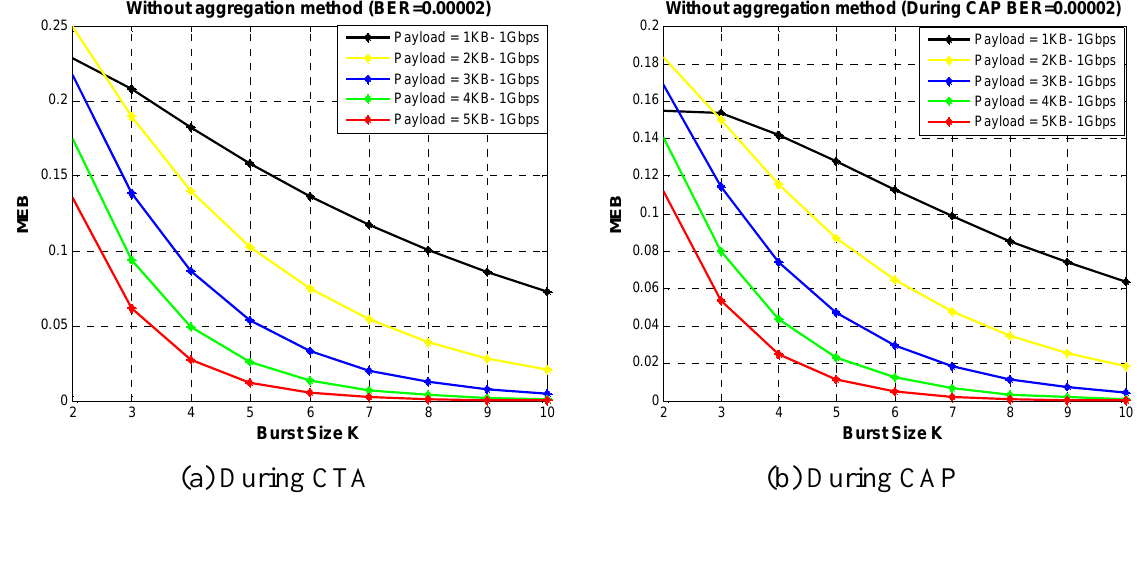
Figure 17. MEB versus burst size with